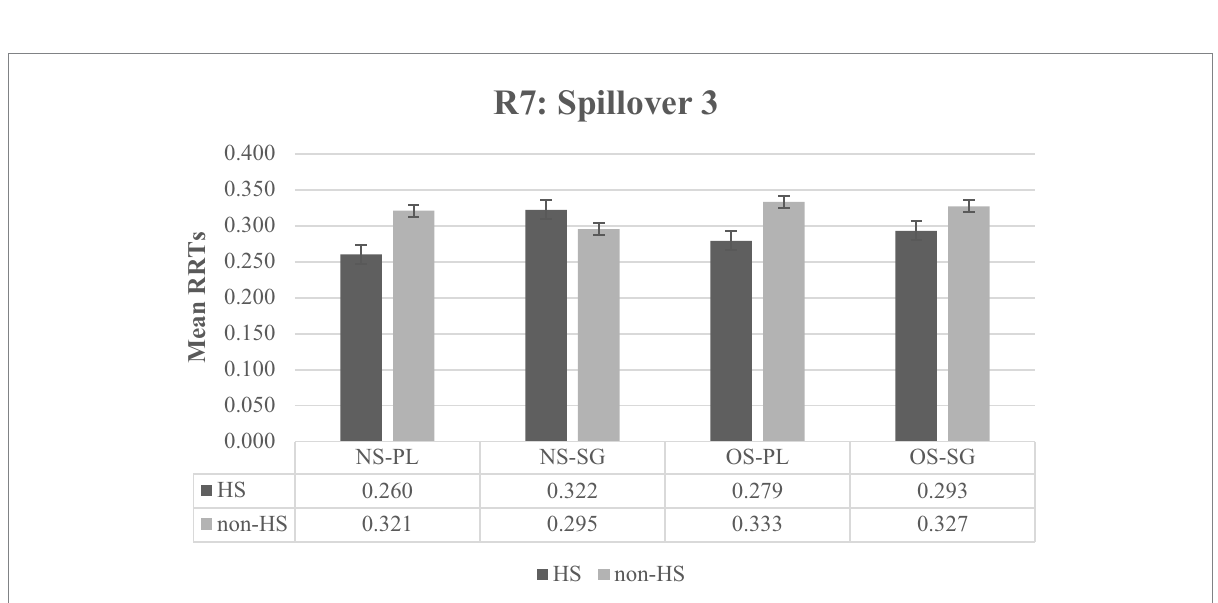
FIGURE 5 Mean RRTs of both groups for Region 7 (Spillover 3). RRTs, Residual reading times; HS, Heritage speakers; non-HS, Non-heritage speakers; NS, Null subject; OS, Overt subject; PL, Verb is plural-marked; SG, Verb is unmarked.